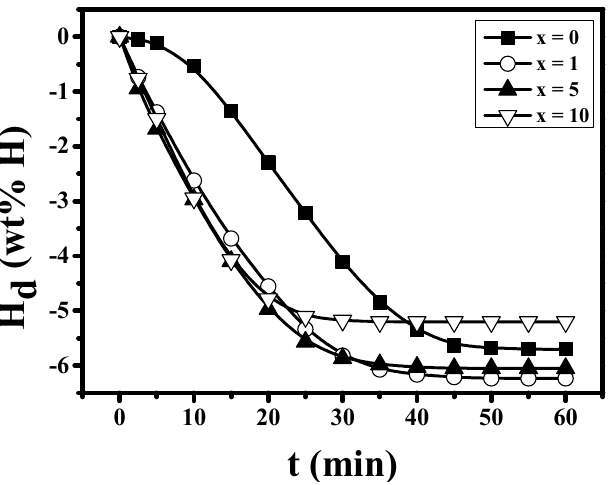
Figure 5. H d versus t curves at 593 K under 1.0 bar H 2 at n = 1 for Mg-xMgH 2 -1.25Ni-1.25TaF 5 -1.25VCl 3 (x = 0, 1, 5, and 10).